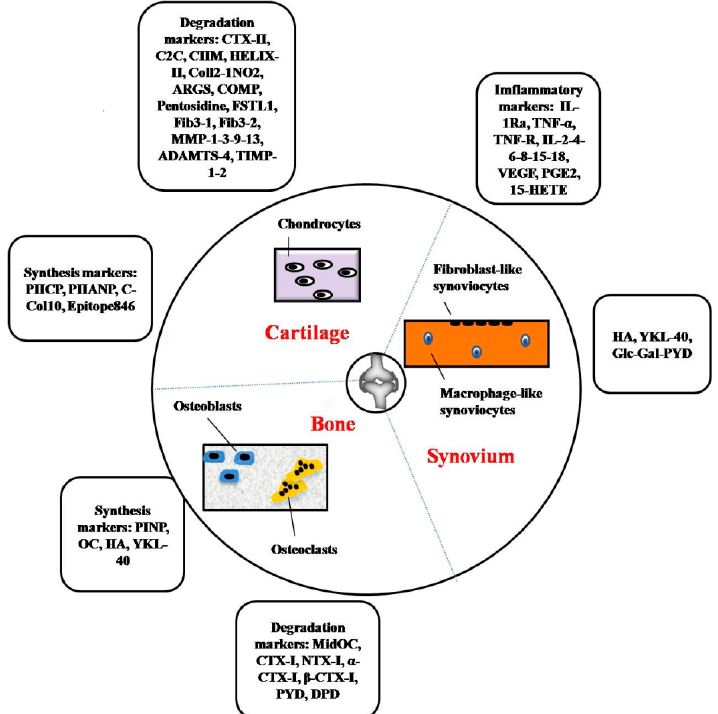
Figure 2. Schematic diagram of cartilage-, bone- and synovium-derived markers in osteoarthritis. Articular cartilage, subchondral bone and synovium are the main sources of many osteoarthritis markers. Generation of these molecular markers is closely related to metabolism of bone, cartilage and synovium via activities of chondrocytes, osteoblasts, osteoclasts and synoviocytes. In addition, inflammatory markers, such as growth factors and cytokines, are derived from the activities of chondrocytes, macrophages and even osteoblasts and osteoclasts.